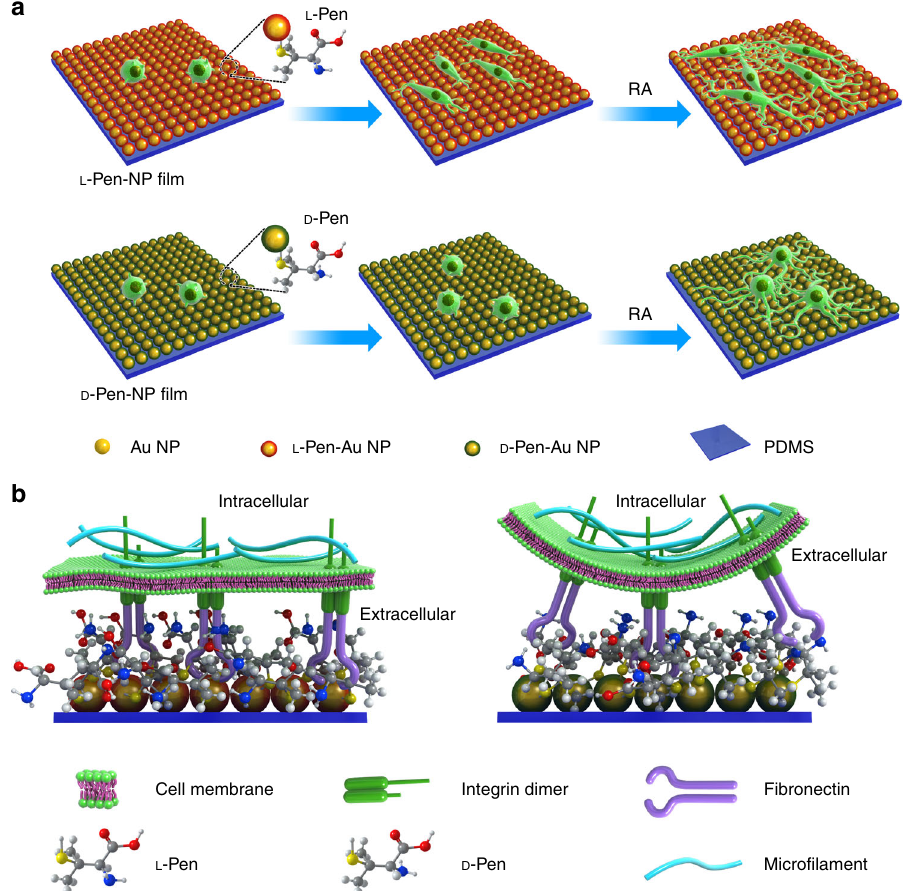
Fig. 1 Interactions between chiral NP fi lms and NG108-15 cells. a Schematic representation of NG108-15 cells grown and differentiated on chiral plasmonic fi lms. b Schematic presentation of the regulation of NG108-15 cell adhesion by stereospeci fi c interaction between fi bronectin and chiral NP fi